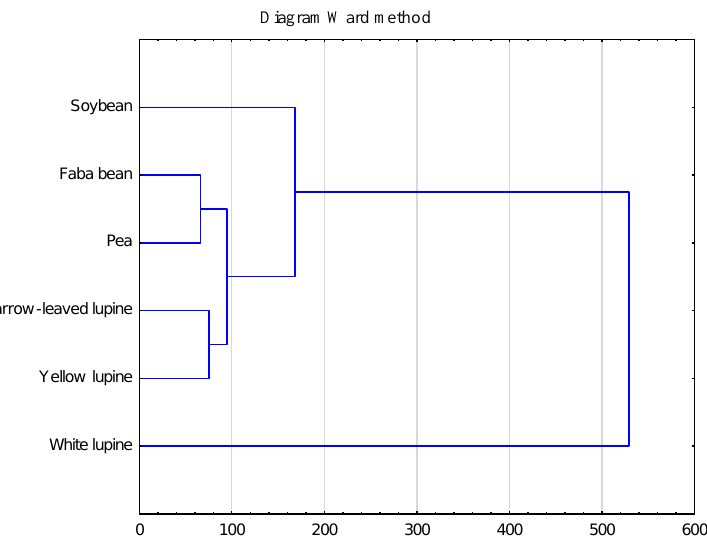
Figure 4. Dendrogram similarity of the chemical composition and macro- and micronutrients of legume seeds evaluated. Fo rdoński et al. [38] obtained similar dendrogram results. The chemical composition of faba bean and pea was similar but different from that of narrow-leafed lupin. Positive and negative correlations between the individual components were also ev- ident for the traits analyzed (Figure 5). It was shown that seed yield (r = 0.82) was very strongly positively correlated with protein yield. Seed protein content was highly nega- tively correlated with fat but positively highly correlated with K content and highly cor- related with the content of Mg. Ash was highly correlated with Mg and K contents, while fiber showed a very strong correlation with the content of Ca. Csajbók et al. [46] showed